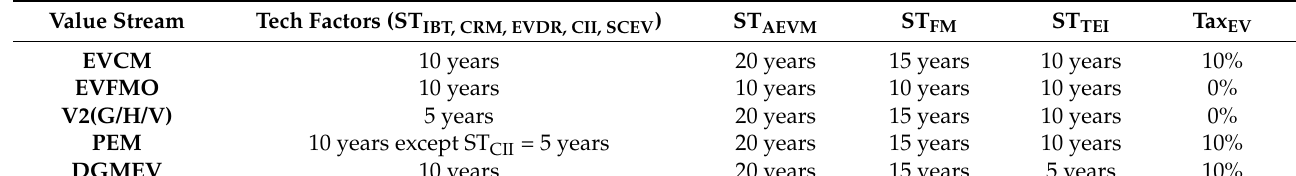
Table 3. Value-stream mapping with EV proliferation factors aid in analyzing the timelines to be met for each factor influencing individual value stream.